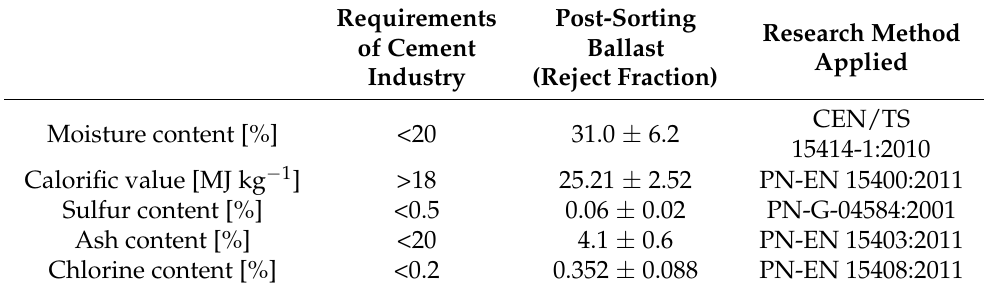
Table 4. Physicochemical parameters required in cement industry and those of reject fraction obtained in the